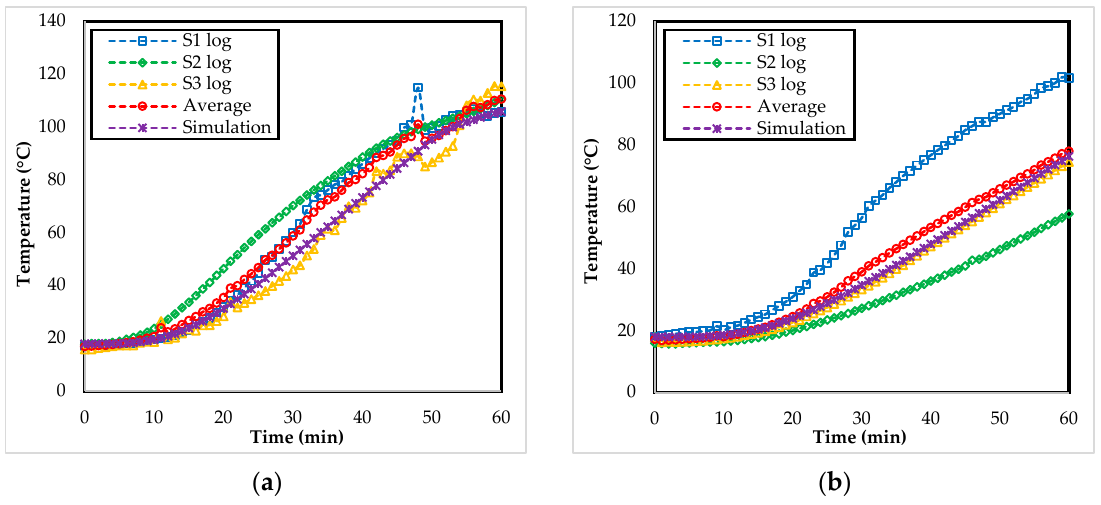
Figure 10. Temperature profile: ( a ) depth of 80 mm (logs); ( b ) depth of 100 mm (logs).